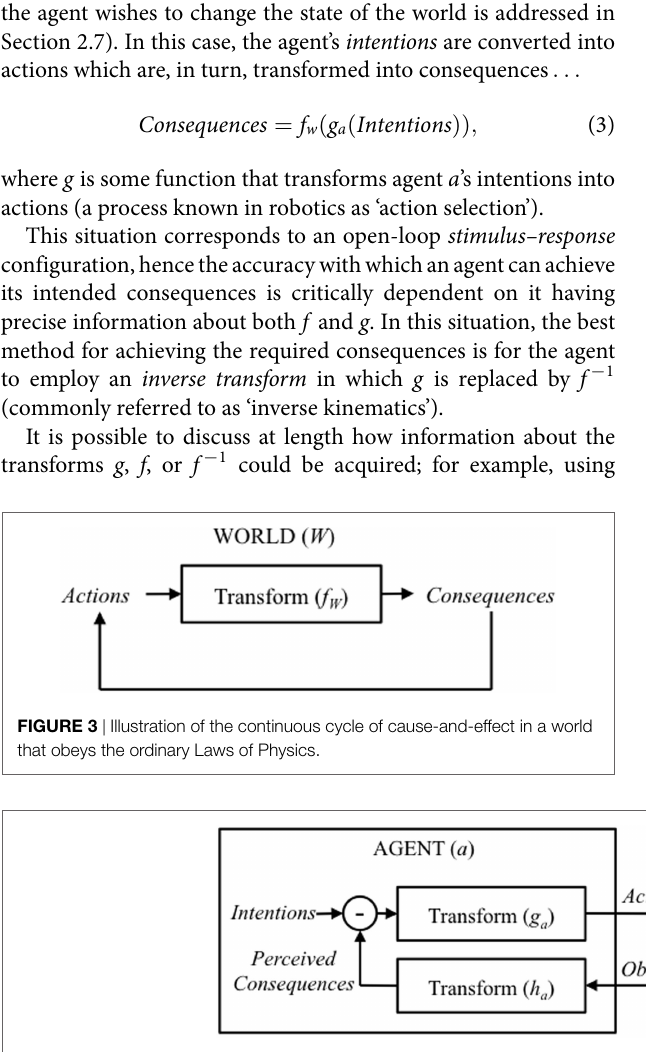
FIGURE 4 | Illustration of an intentional agent manipulating the world in a closed-loop negative-feedback configuration.